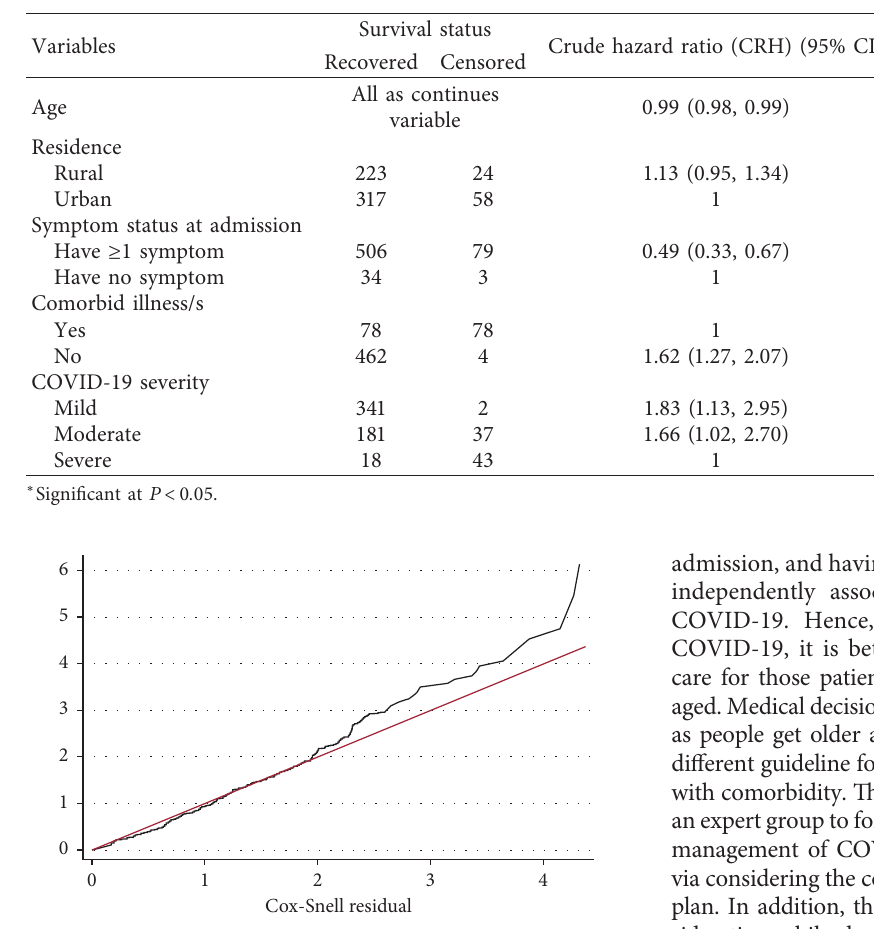
Table 3: Multivariable Cox proportional hazards analysis of predictors of time to recovery from COVID-19 in Amhara region COVID-19 centers, 2021 ( n � 622).